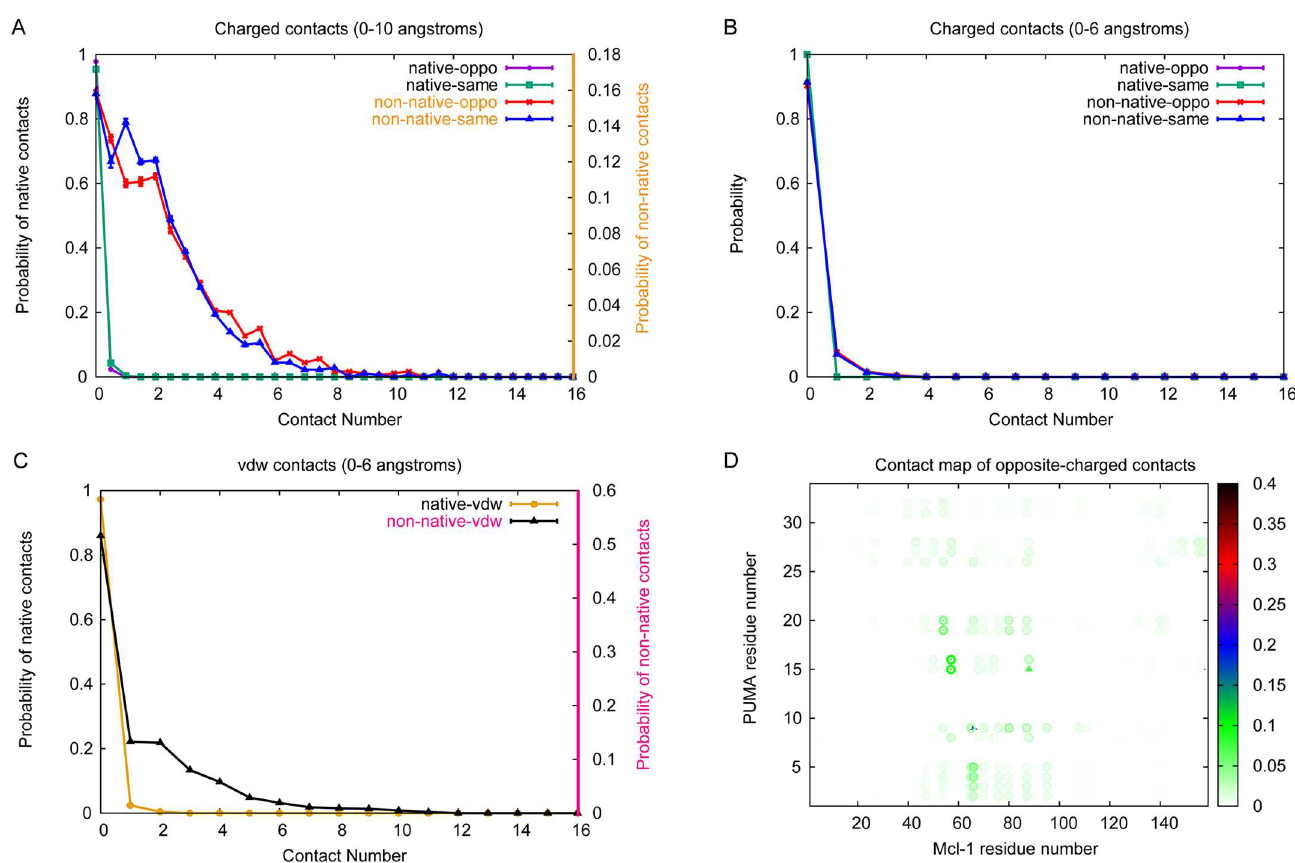
Fig 7. Contact number distribution and contact map without electrostatic interactions. Simulations in the absenceof electrostatic forces indicate altered propertiesfor the encountercomplex. (A-C) Probabilitydistributionsof contact numberswithin encounter complex. Standard errors of data are shown. (D) Contact map of opposite-chargedcontacts within encounter complex for simulations without electrostatic forces included. All other parameters are the same as simulations performed with charges(IS = 10 mM).